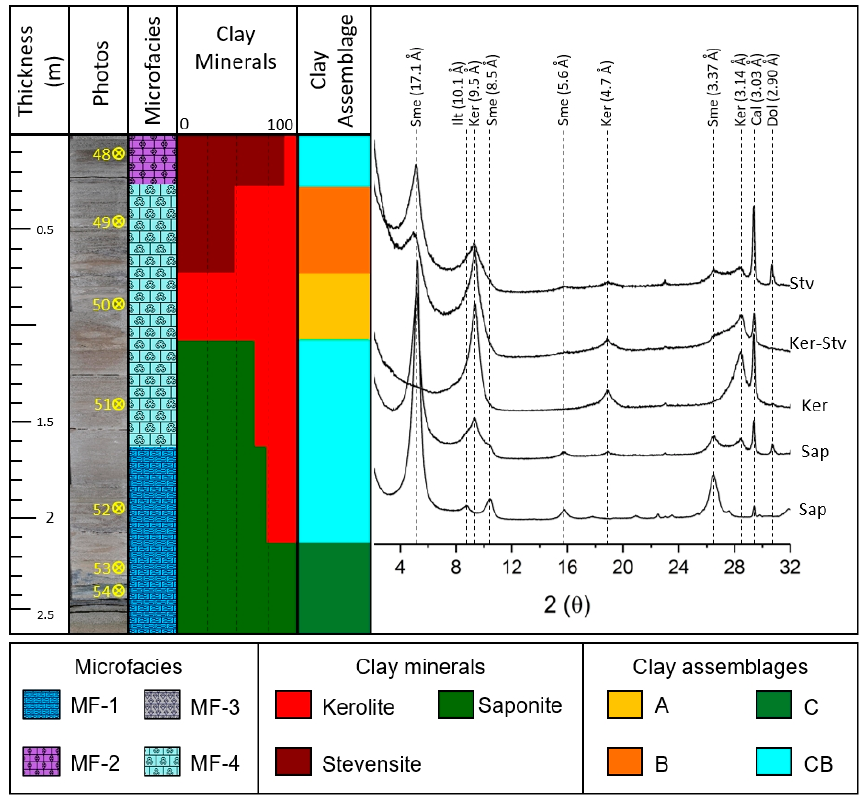
Figure 5. Mineralogical sequence 1. The rocks, clay minerals, assemblages and representative XRD patterns are shown. Ker. Kerolite. Sme (smectite), Ilt (illite), Cal (calcite) and Dol (dolomite).